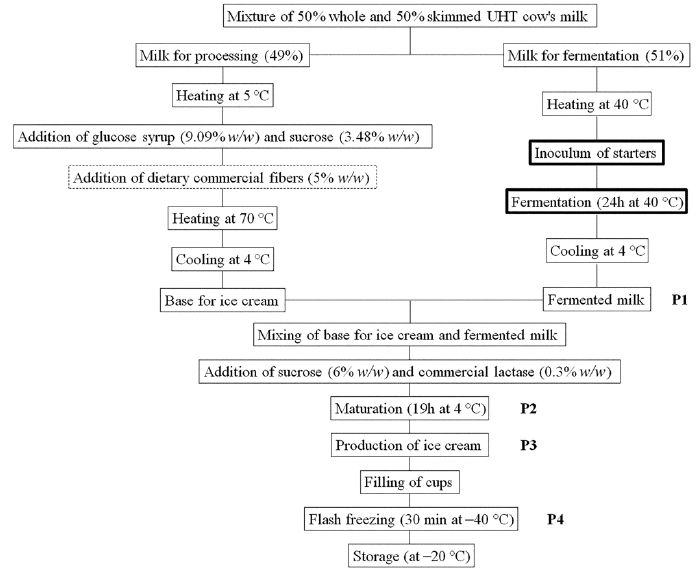
Figure 1. Manufacture of ice cream with fermented milk. The step in the dotted text box (“Addition of dietary commercial fibers (5%, w/w)”) was made only for the theses with the addition of fibers, while this step was not made for the theses without the addition of fibers (in this case the total amount of fibers is 0.2%, w/w). The control’s theses CO were made with the same protocol exception being the steps in bold rectangles that were not included: “Inoculum of starters” and “Fermentation (24 h at 40 °C)”. P1–P4 indicates the sampling points during the ice cream preparation. Table 1. Conditions considered in this study. The sample codes are presented in the form XX.YY. where XX indicates the thesis (I1. I2. I3. I4, and CO) and YY represents the addition of dietary commercial fibers (AF means with the addition of 5% w / w dietary commercial fibers. WF means without the addition of fibers). When dietary commercial fibers were not added, the total amount in ice cream was 0.2% w / w . “.H” suffix represents the addition of 50 ppm of HT. Code (XX.YY.(H))